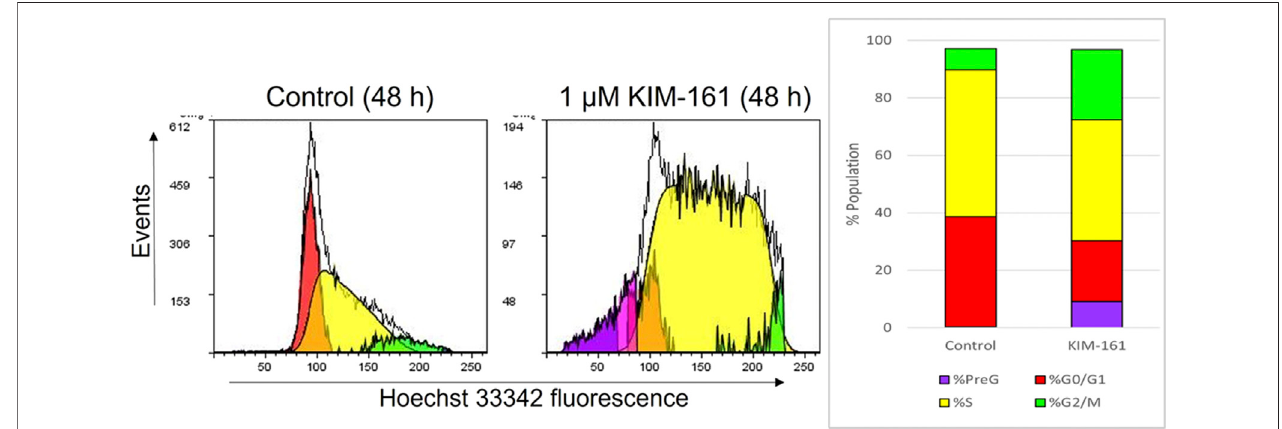
FIGURE 3 | Effect of KIM-161 (1 µM) on HL60 cell cycle compared to untreated cells (control) for 48 h.